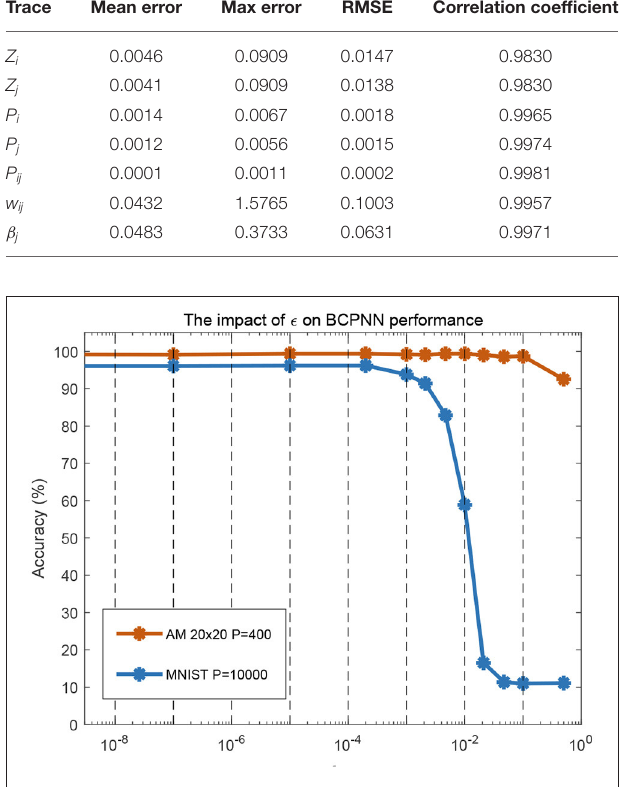
FIGURE 11 | Software simulation of the impact of ε on BCPNN performance in associative memory (AM) storage capacity and handwritten digit recognition (MNIST). For AM, a network configuration of H × M = 20 × 20 was tested for storage of 400 patterns. For MNIST, all 10,000 test patterns were